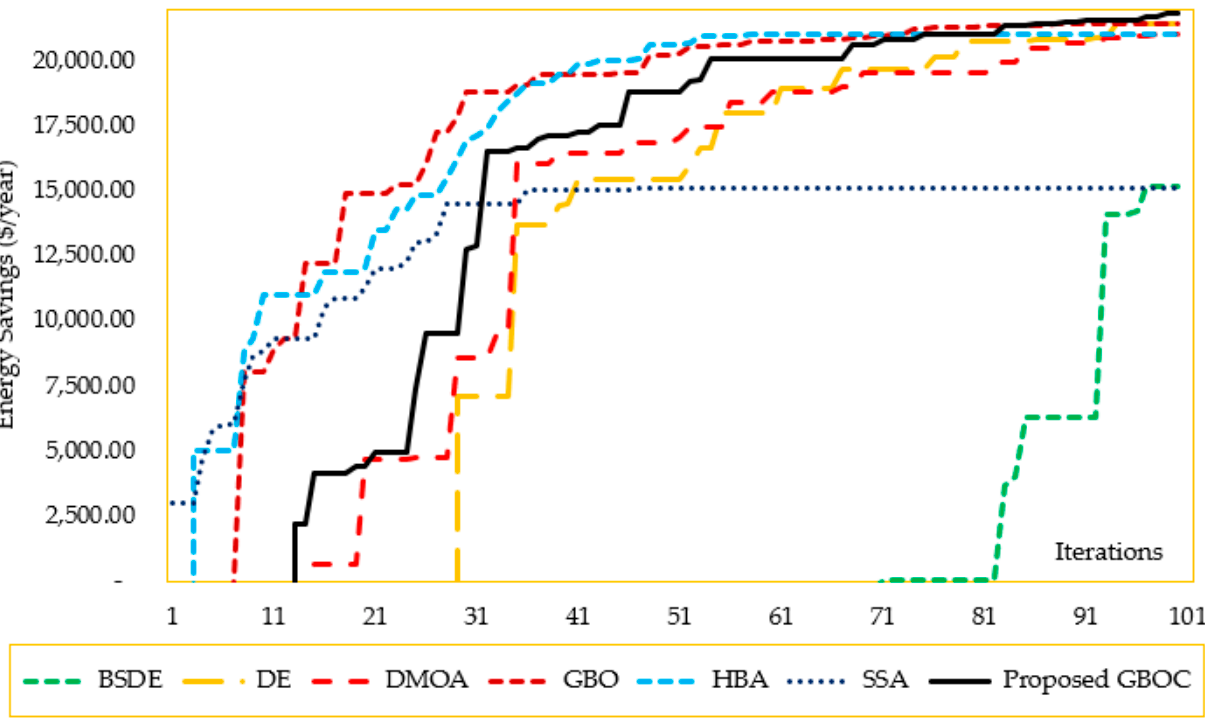
Figure 4. Convergence characteristics of GBOC, GBO, SSA, DMOA, DE, and HBA for the IEEE 33-distribution system for Scenario 1.